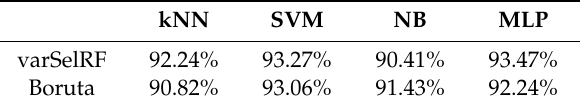
Table 5. Average classification accuracy for scenario-type detection.